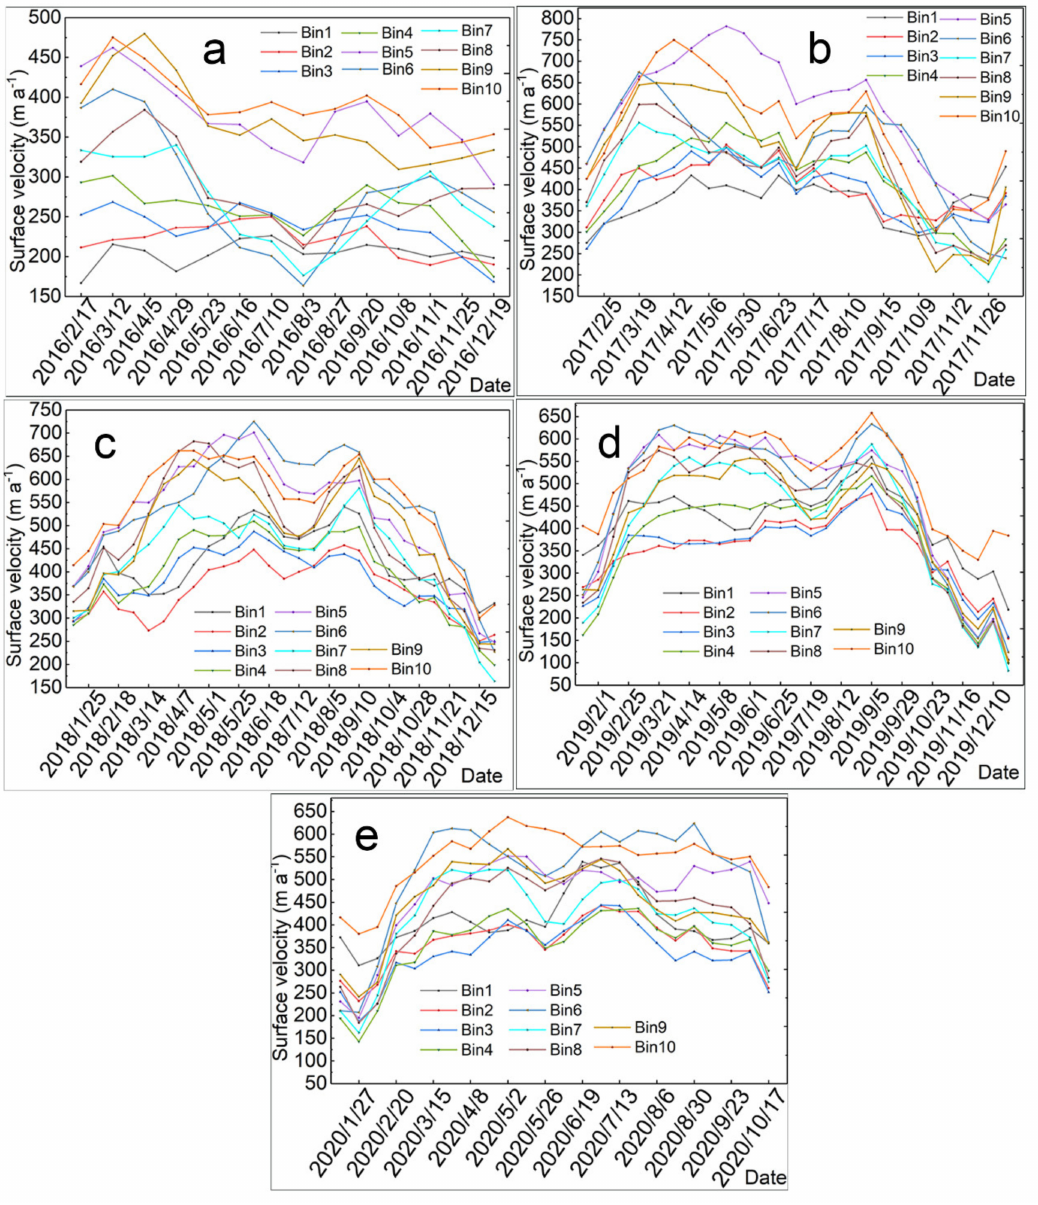
Figure 7. The velocity retrieval results from 17 February 2016 to 17 October 2020 displayed by year. Panel ( a – e ) respectively represent the surface velocity from 2016 to